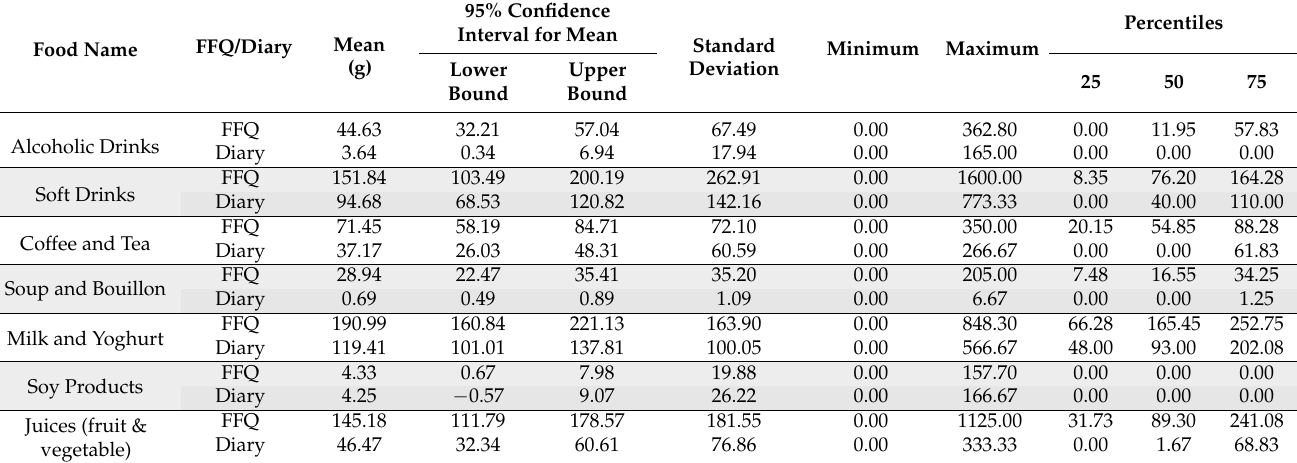
Table A5. Descriptive of the total study population (mean ± standard deviation; Min. P25. P50. P75 and Max; 95% confidence interval). Descriptive oldest group (14–17 years); n =